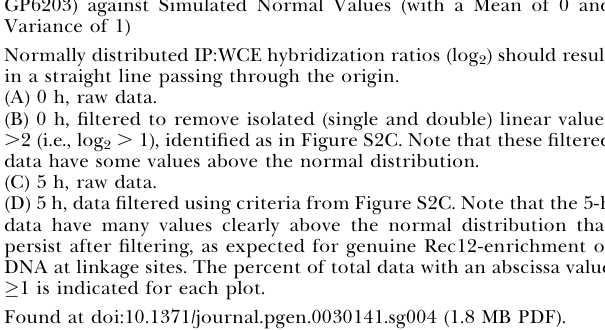
Figure S5. Distribution of Rec12-DNA Linkages in Two Haploid Inductions (Strain GP6013) and One Diploid Induction (Strain GP6203) Are Similar Data for Not I fragment J are filtered and presented as in Figure S2C. Found at doi:10.1371/journal.pgen.0030141.sg005 (1.9 MB PDF). Figure S6. Southern Blot Analyses of DSBs in the 1.8-Mb Region at the Left End of Chromosome I (A) Physical map and Southern blot hybridizations of Not I fragments encompassing 0.2–2 Mb from the left end of Chromosome I probed from the right (R) or left (L), as indicated. Haploid strain GP5411 ( rad50S ) was induced, and at the times indicated DNA was extracted and analyzed for DSBs by Southern blot hybridization as described by Young et al. [5]. (B) Coarse mapping of DSB positions from Figure S6A Not I blots. (C) Finer scale mapping of the DSB sites identified in Figures S6A and S2C was carried out using DNA from haploid strain GP5411